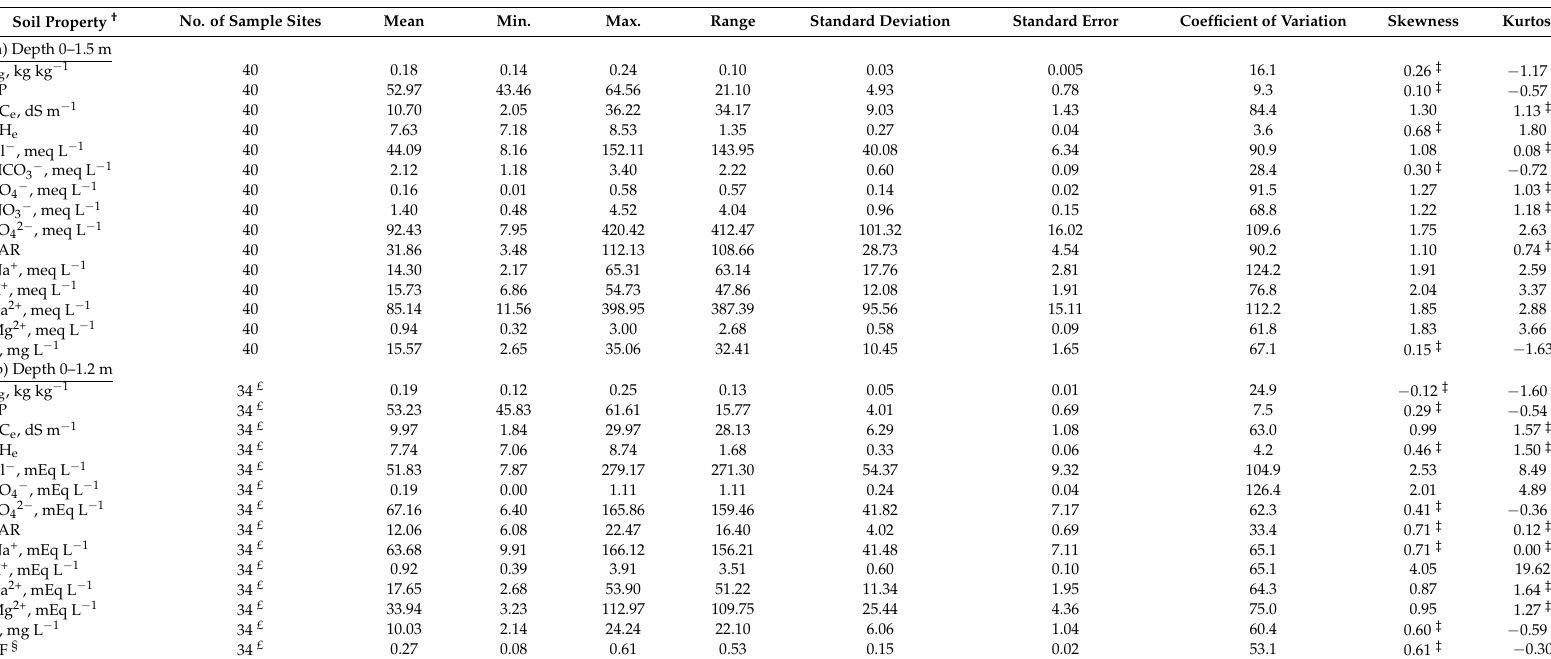
Table 2. Soil edaphic property mean and range statistics of the composite depths of (a) 0–1.5 m and (b) 0–1.2 m for the combined full-field (20 soil sample locations) and southeast-corner (20 soil sample locations)